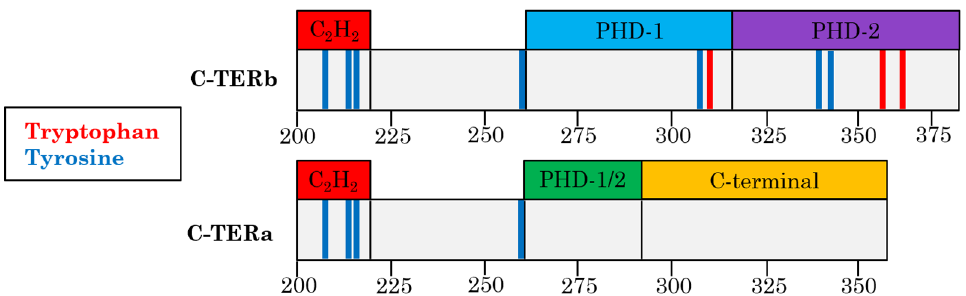
Figure 1. Domains and aromatic residue organisation of C-TERb ( upper panel) and C-TERa ( lower panel). C-TERb contains three zinc finger domains (from left to right), namely Krüppel-like C 2 H 2 (red), PHD-1 (turquoise), and PHD-2 (purple). C-TERa contains (from left to right) one zinc finger, the Krüppel-like C2H2 (red), as well as a truncated PHD finger, PHD-1/2 (green), and a C-terminal domain (yellow). On each schematic sequence, tryptophan residues (Tyr) are represented by red sticks and tyrosine residues (Tyr) by blue ones.